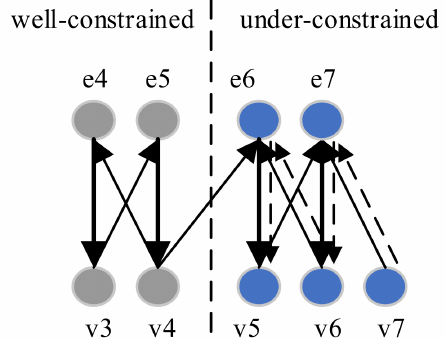
Figure 5. Feasible paths from exposed variable v